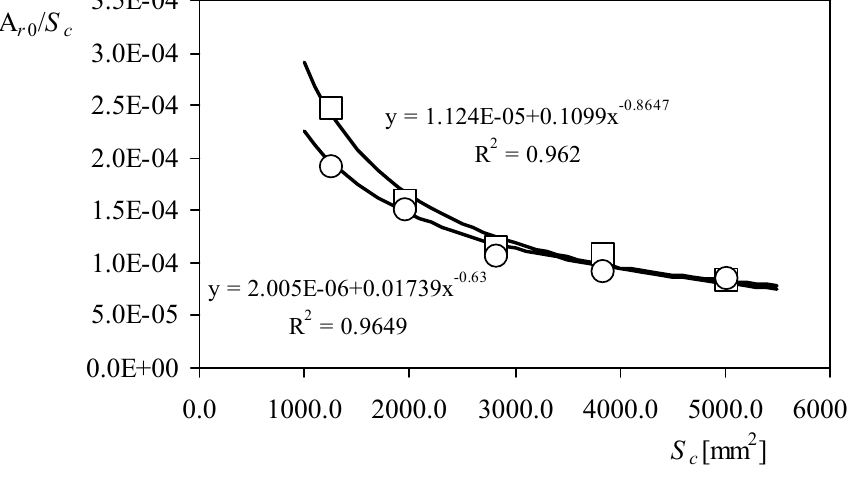
. Data correspond to the Climatronics 100075 c